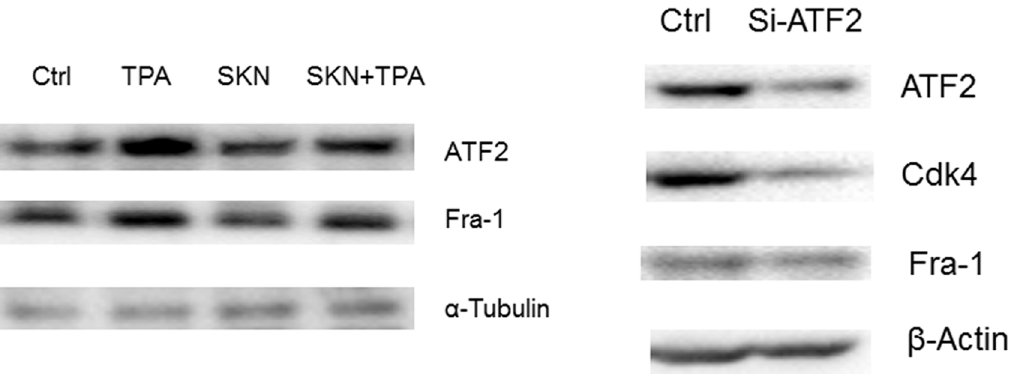
Fig 3. Detection of the expression levels of ATF2 and Cdk4 in mouse epidermal JB6 P+ cells. Left panel, JB6 cells were pretreated with shikonin (1 μ M) for 30 min following by TPA (5 nM) treatment for 24 h. Nuclear extract was prepared and used for Western blot analysis. Right panel, JB6 P+ cells were transfected with siRNAs for 48 h and whole cell lysate was prepared for Western blot